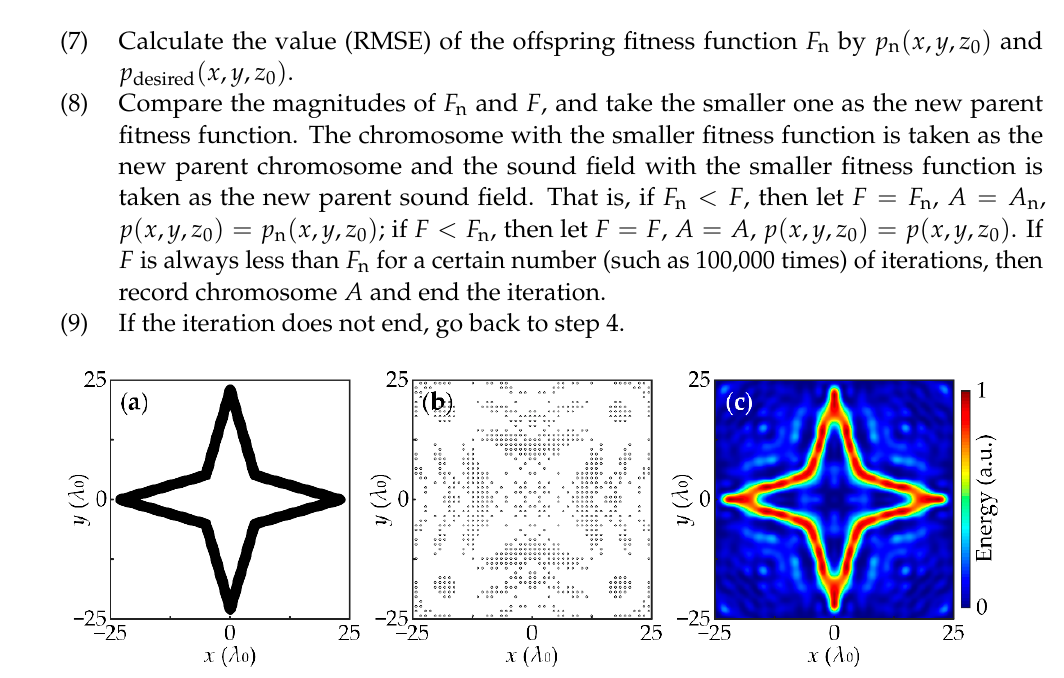
Figure 2. Holographic imaging based on the PS array. The background medium is chosen as air with a sound velocity c 0 = 340 m/s and a density ρ 0 = 1.2 kg/m 3 , and the radiation frequency is set at f 0 = 34 kHz, so the wavelength is λ 0 = c 0 / f 0 = 10 mm. ( a ) Desired image (a four-pointed star). The black parts in the figure represent the presence of sound energy with equal magnitudes (the sound energy at these locations can be considered to be 1), and the white parts represent the absence of sound energy (the sound energy at these locations can be considered to be 0); ( b ) The overall map of the hologram based on the PS array designed by the modified genetic algorithm. Each black dot represents a PS. The distance between grid nodes is D = λ 0 and the distance of the desired image plane from the hologram is z 0 = 120 λ 0 ; ( c ) Normalized energy distribution in the image